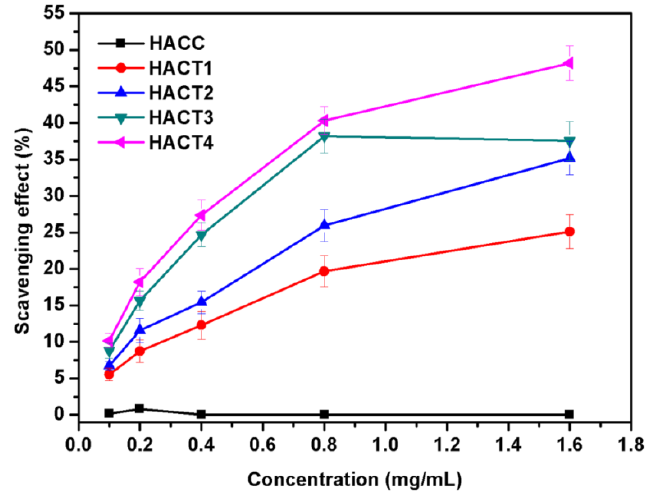
Figure 6. DPPH radical scavenging activity of chitosan derivatives.